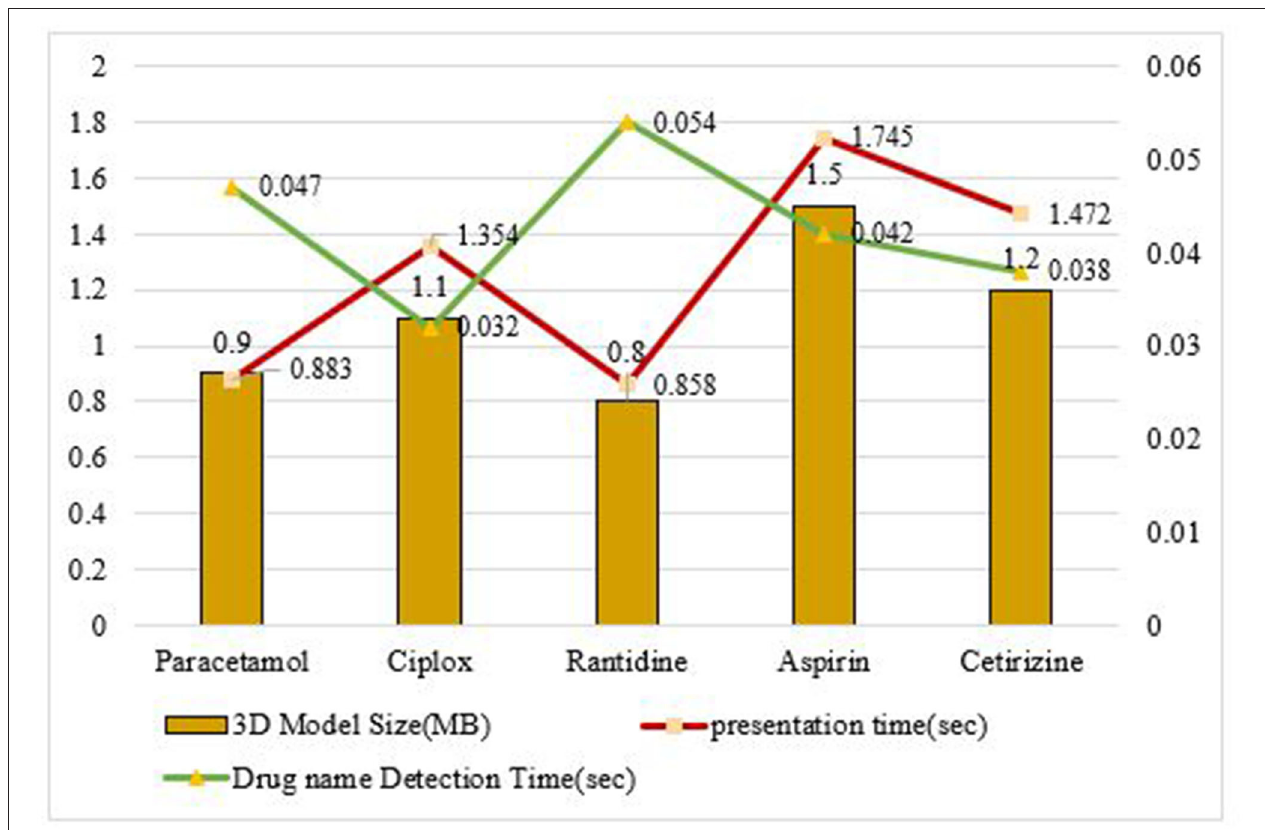
FIGURE 8 | Response time for corresponding drug name detection and 3D model presentation.